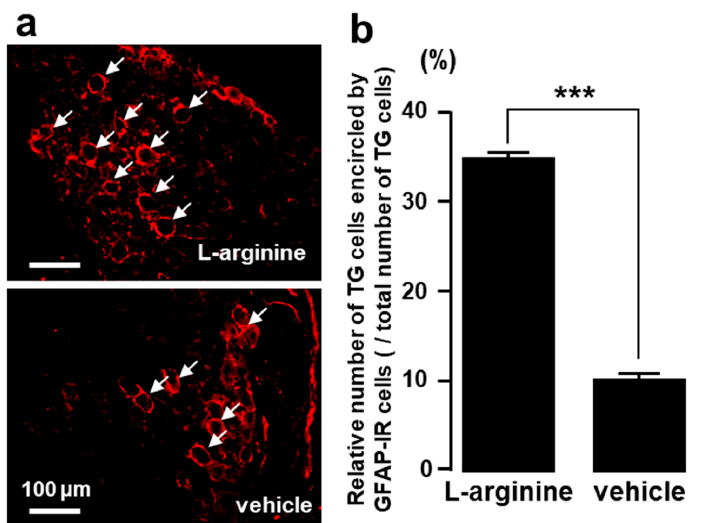
Figure 5. The effect of L-arginine administration into TG on the expression of GFAP-IR cells in TG. ( a ): Photomicrographs of GFAP-IR cells in TG, ( b ): Relative number of TG cells encircled by GFAP-IR cells. The arrows indicate TG cells encircled by GFAP-IR cells. ***: p < 0.001. n = 5 in each group.